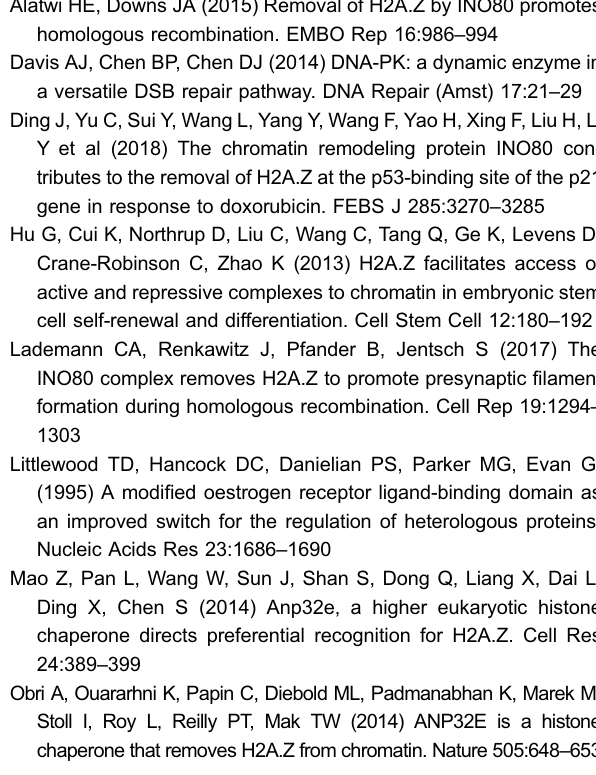
Figure 2. DNA-PKcs-containing components possessed H2A . Z-H2A replacement enzyme activity. (A) Schema of puri fi cation steps. (B) DNA-PKcs protein peak in the SW4000 puri fi cation fractions. (C) Enzyme activity is consistent with the protein peak of DNA-PKcs. (D) Lost enzyme activity after depletion of DNA-PKcs with speci fi c antibody. (E) DNA-PKcs containing fraction (#35) exhibited ATP-dependent enzyme activity. (F) DNA-PKcs containing fraction was mainly respon- sible for depositing H2A.Z into reconstituted nucleosomes. (G) shDNA-PKcs-mediated reduction of H2A-phosphorylation. (H) Phosphor-modi fi cation of H2A by DNA-PKcs-containing component in in vitro assay. (I) DNA and kinase activity- dependent enzyme activity. (J) Immuno fl uorescence staining to detect H2A.Z (green) and DNA-PKcs (red) dynamic change in Asi SI-ER U2OS cells. DAPI staining shows total nuclei. Scale bar indicates 20 µm. (K) Primers for ChIP-qPCR at proximal and distal to Asi SI site on Chr22 position 19180307. (L) Accu- mulation of H2A.Z at 10 min was observed at proximal to Asi SI site after 4-OHT